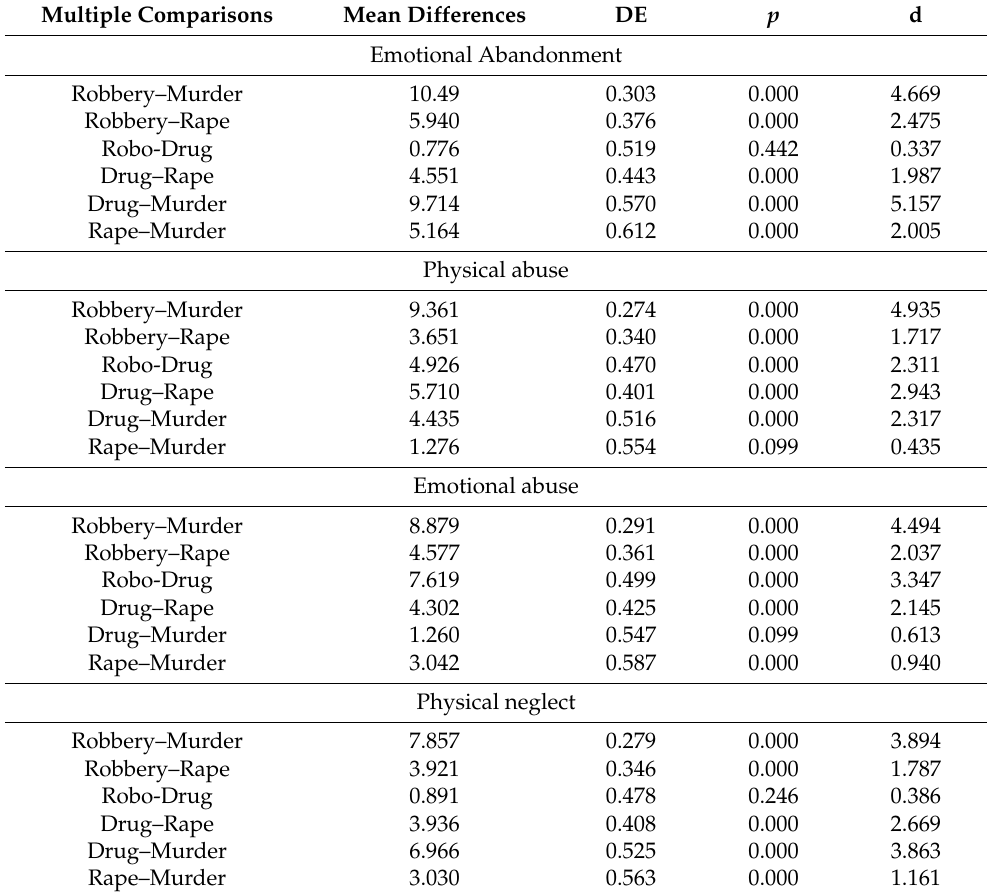
Table 9. Multiple comparisons between types of child abuse and types of